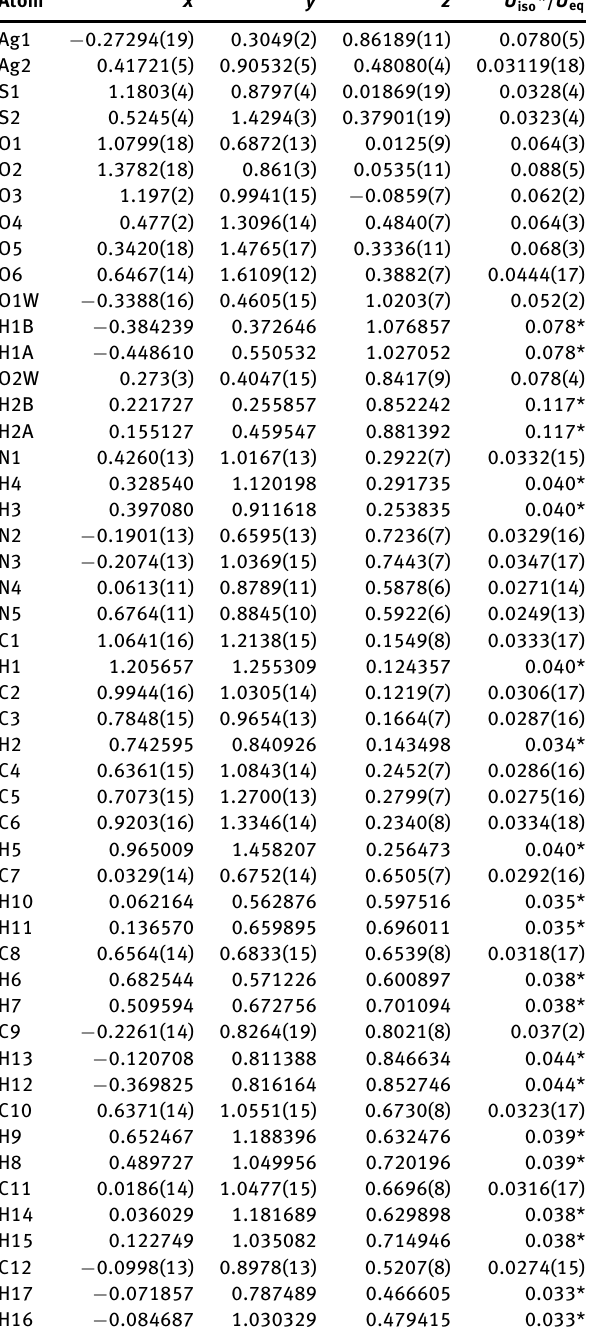
Table 2: Fractional atomic coordinates and isotropic or equivalent isotropic displacement parameters (Å 2